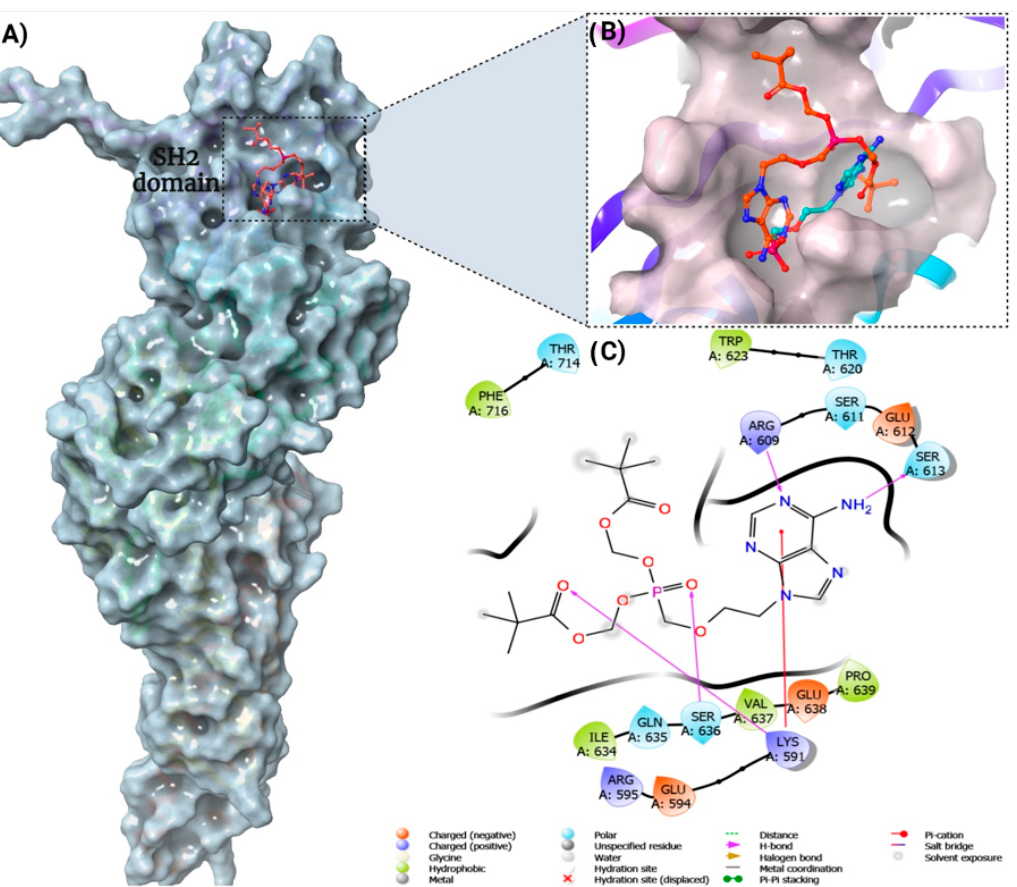
Figure 5. Molecular docking of adefovir dipivoxil and adefovir against STAT3 SH2 domain. ( A ) Docking of Adefovir dipivoxil in STAT3 SH2 binding pocket. ( B ) Overlay of Adefovir dipivoxil and Adefovir Docked Poses in the STAT3 SH2 domain. ( C ) The 2D interaction map of the XP docking pose of Adefovir dipivoxil in STAT3 SH2 binding pocket. Adefovir dipivoxil showed hydrogen